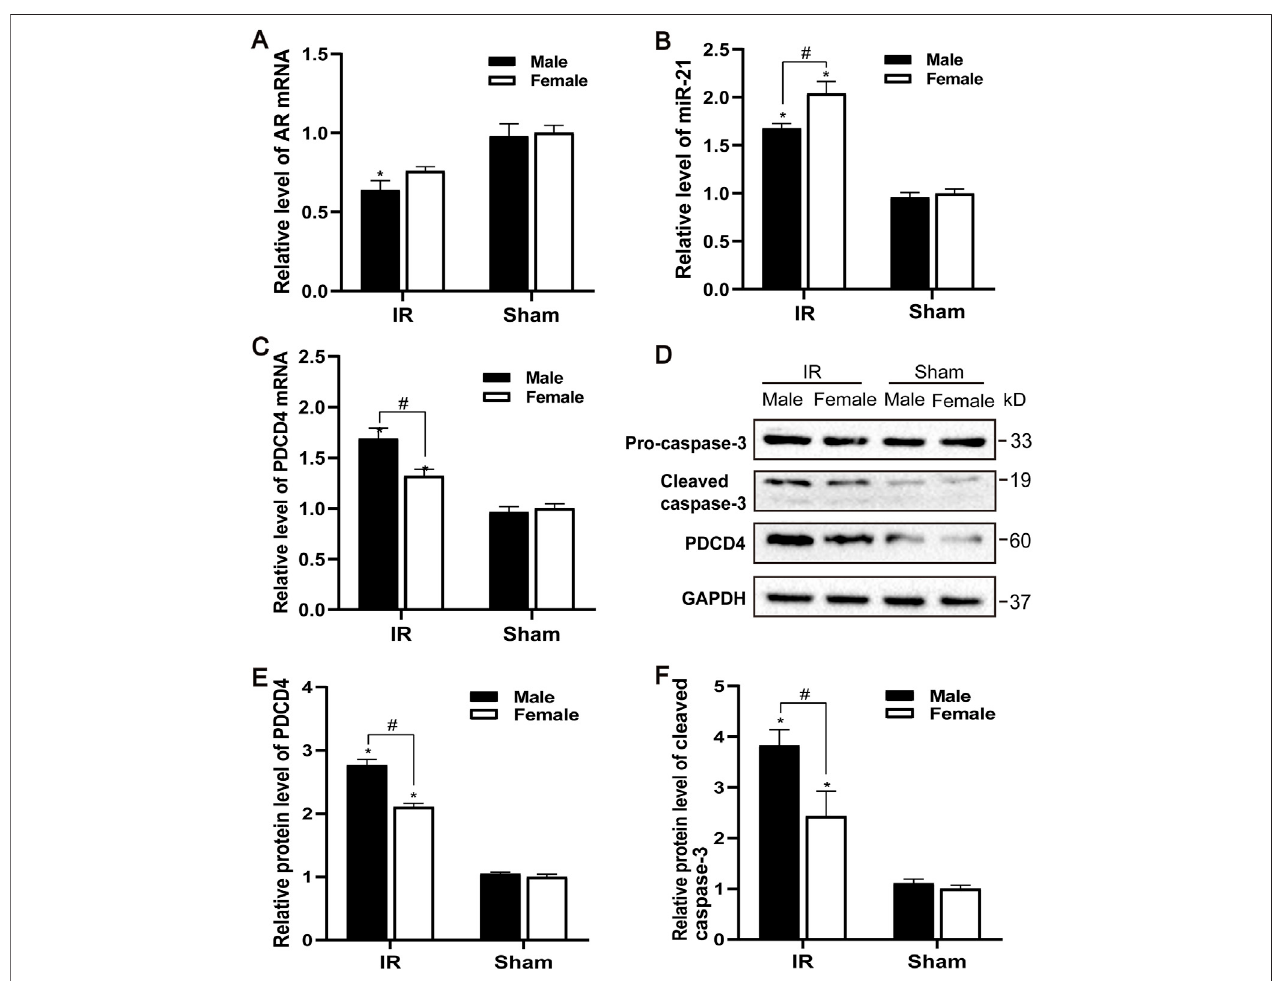
FIGURE2| GenderdifferenceexpressionofARandmiR-21afterrenalIRinjury. (A – C) qPCRshowingAR (A) ,miR-21 (B) ,andPDCD4 (C) mRNAlevelsofmaleand female mice in renal ischemia for 45 min and 24 h after reperfusion. (D) The expression of cleaved caspase-3 and PDCD4 protein in renal tissue after renal ischemia- reperfusion was detected by Western blot. (E) Quantitative evaluation of PDCD4 protein levels in renal tissue. (F) Quantitative evaluation of cleaved caspase-3 protein levels in renal tissue. Data presented are mean ± SEM ( n > 5). Compared with sham operation group, * p < 0.05. Compared with female renal IR group, # p < 0.05.